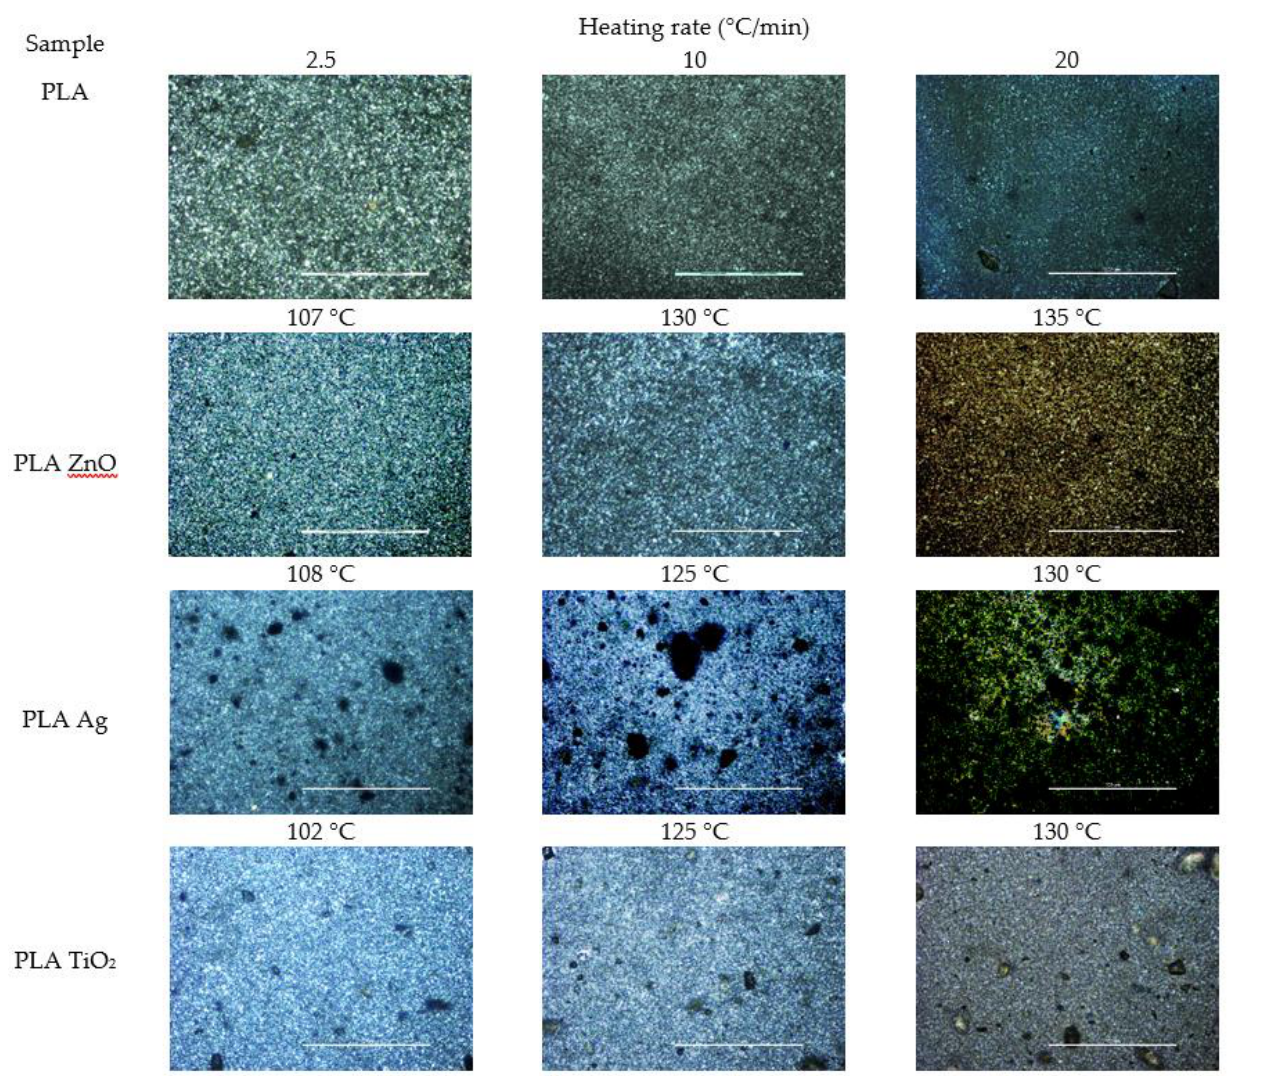
Figure 5. ( a ) Dobreva plots and ( b ) nucleation activity of PLA and its nanocomposites during their non-isothermal cold crystallization after fitting the data of the heating rates 2.5, 5, 7.5, and 10 °C/min.